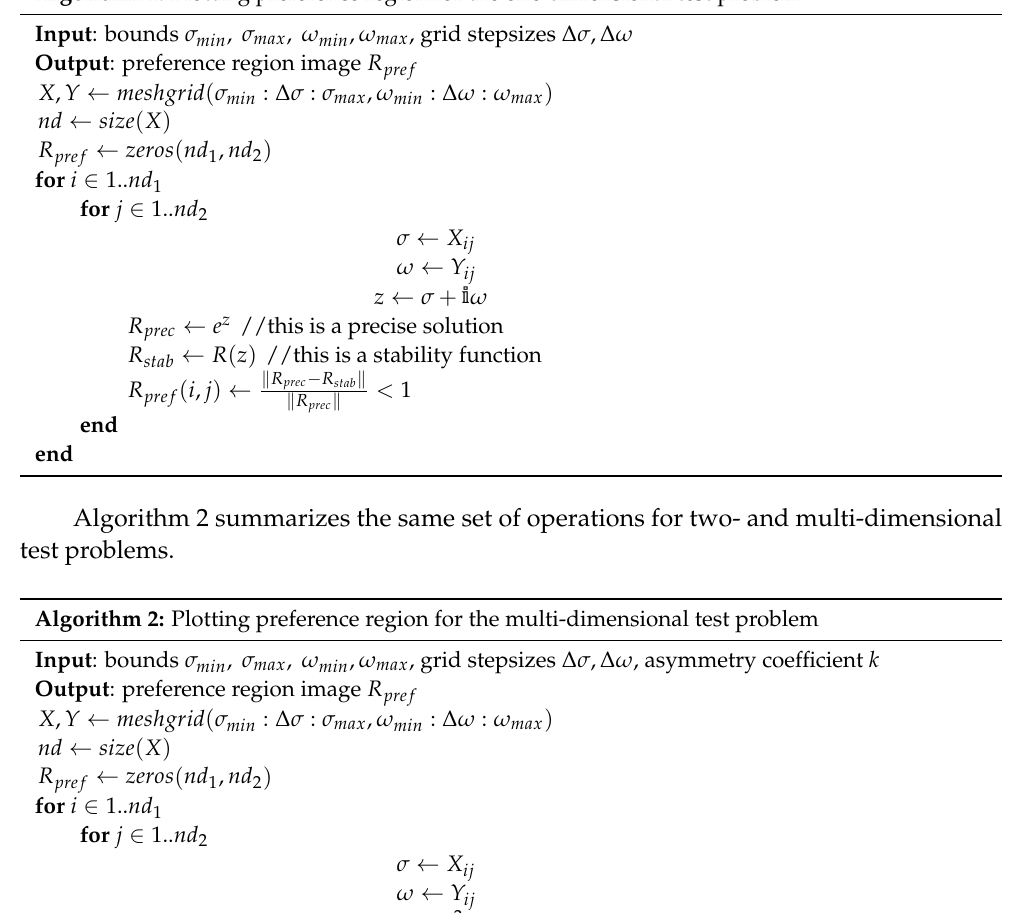
Algorithm 1: Plotting preference region for the one-dimensional test problem